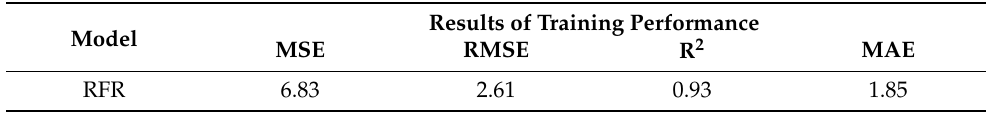
Table 6. The training phase (compressive strength) with available RFR models’ yielded statistical data from the applied prediction models.